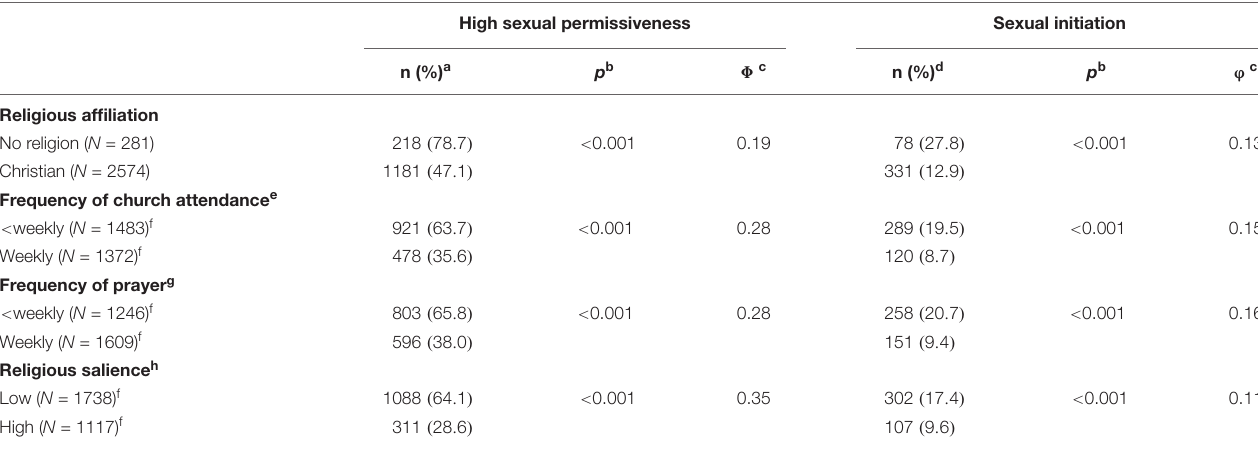
TABLE 2 | Sexual permissiveness and sexual initiation, by religiosity